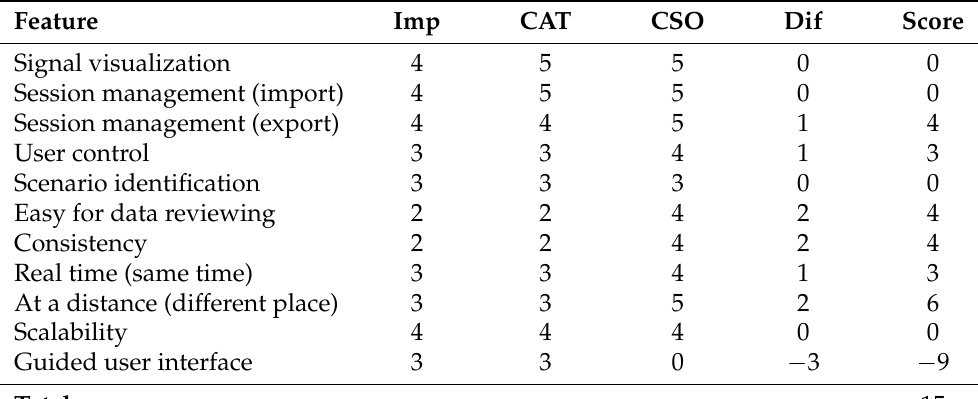
Table 4. Results of MuseStudio’s evaluation.